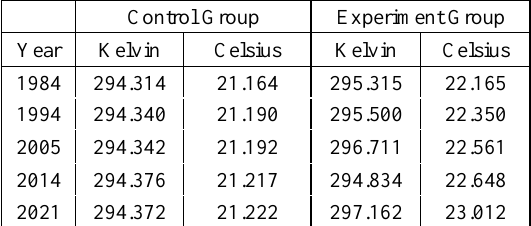
Table 4. The average temperature changes of the control